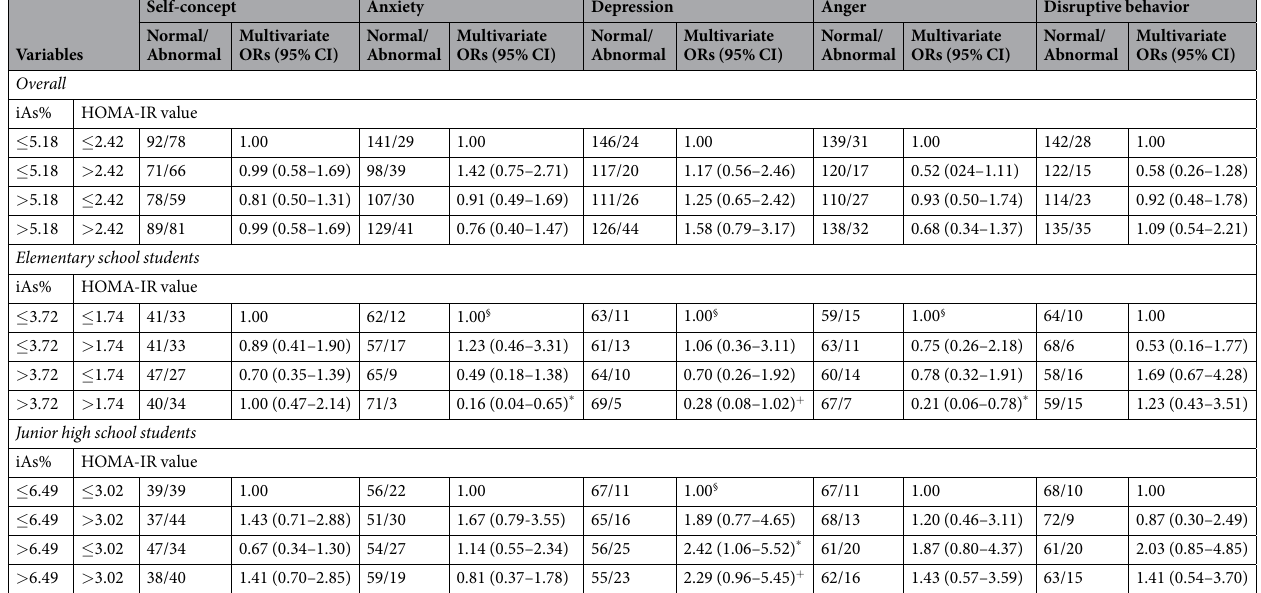
Table 6. The interaction of iAs% and HOMA-IR value on psychological characteristics. ORs, odds ratios; CI, 95% confidence intervals. Multivariable logistic regression analyses were adjusted for covariates, indicated age, gender, schools, father’s educational levels, mother’s educational levels, BMI, body fat, and urinary creatinine.